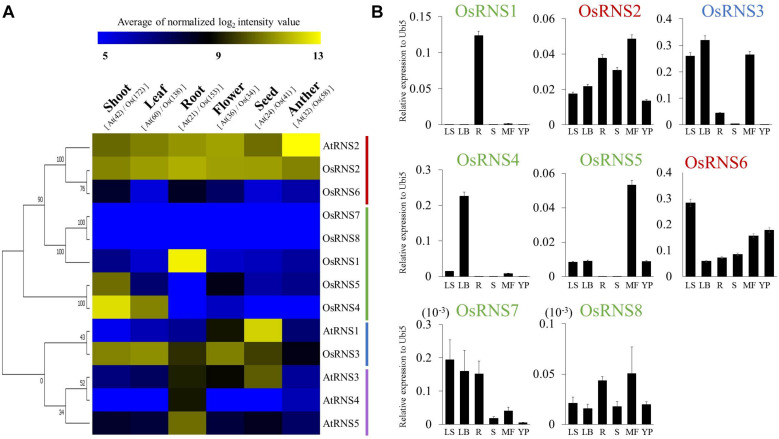
Anatomical meta-expression analysis of data from Affymetrix array platforms, and validation of the meta-expression patterns of eight RNS genes in various tissues/organs via qRT–PCR. (A) Affymetrix expression data from six tissues/organs were used to create the heat map with the MeV software. Blue, low levels of expression; yellow, high levels of expression. (B) qPCR was performed in six tissues/organs (LS, leaf sheath; LB, leaf blade; R, root; S, developing seeds; MF, mature flowers; and YP, young panicle). X-axis, tissues/organs used for qPCR analysis; Y-axis, relative expression level compared with that of rice ubiquitin 5 (OsUbi5, LOC_Os01g22490). Four biological replicates were prepared and analyzed independently. The numbers on the heat map in (A) represent the number of Arabidopsis (At) and rice (Os) samples for each organ. In (B), green letters indicate class I monocot-specific RNS; blue letters indicate class I common RNS; and red letters indicate class II RNS.